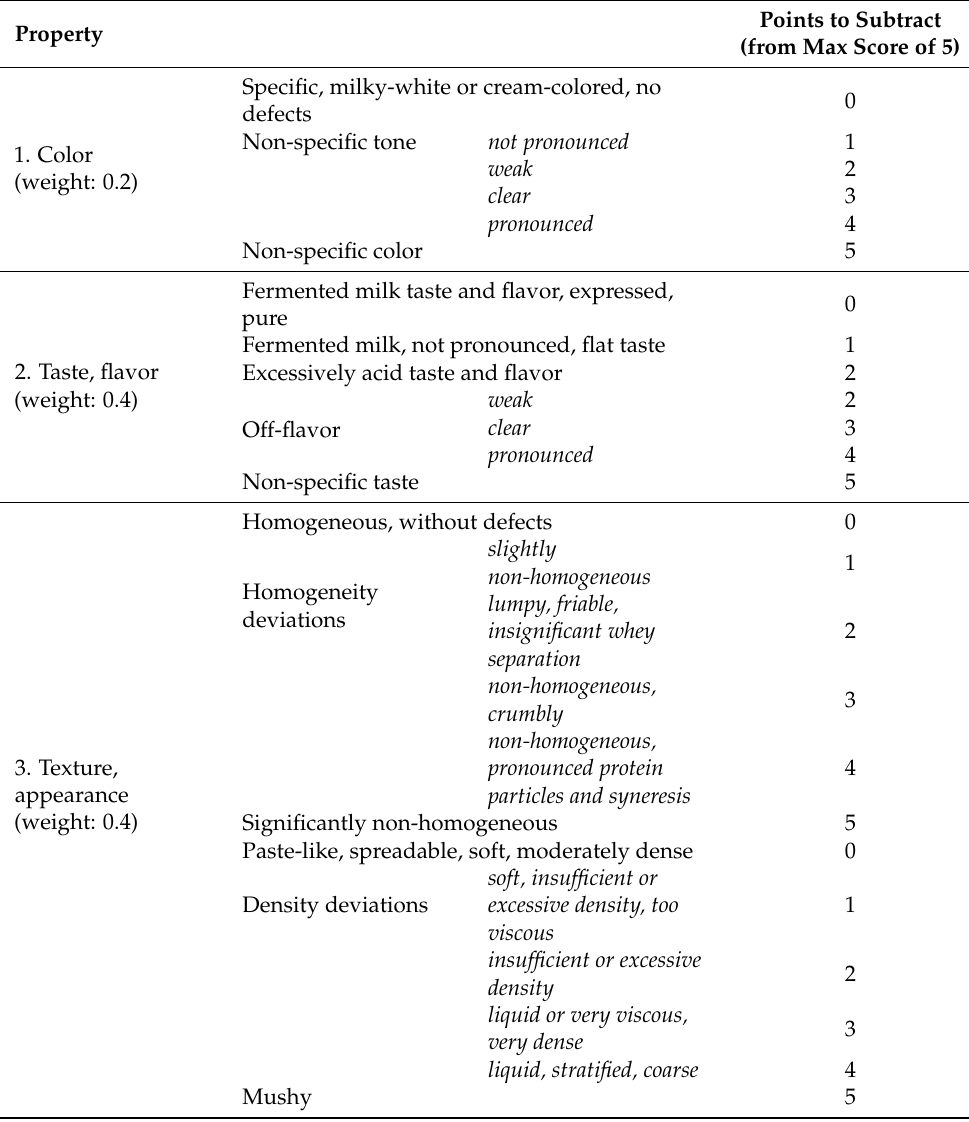
Table 9. Organoleptic properties of the curd